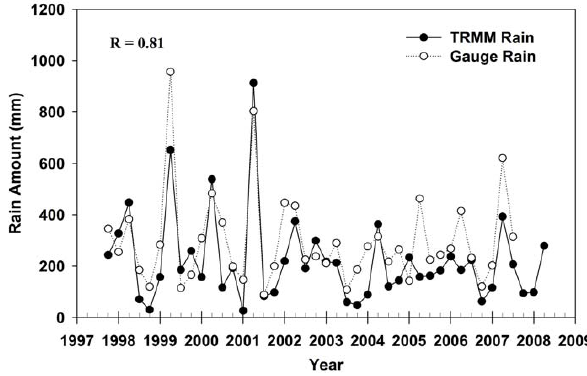
Figure 1 . Seasonal precipitation amount estimated from TRMM PR and measured from surface rain gauge from 1998 to 2009 in Shanghai.